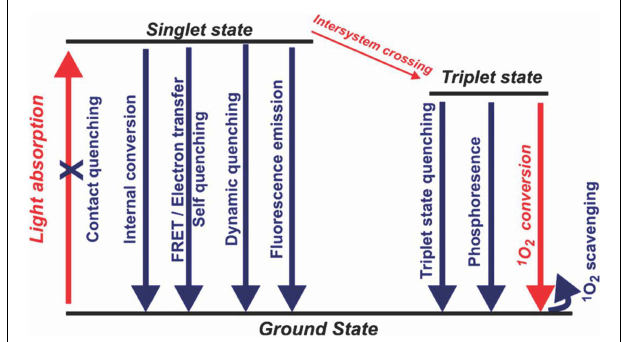
FIGURE 4 | Possible pathways for rational deactivation of an excited state photosensitizer. Simplified singlet oxygen generating diagram with energy levels shown in black and the typical pathway of singlet oxygen generation in red (Adapted with permission from Lovell et al.